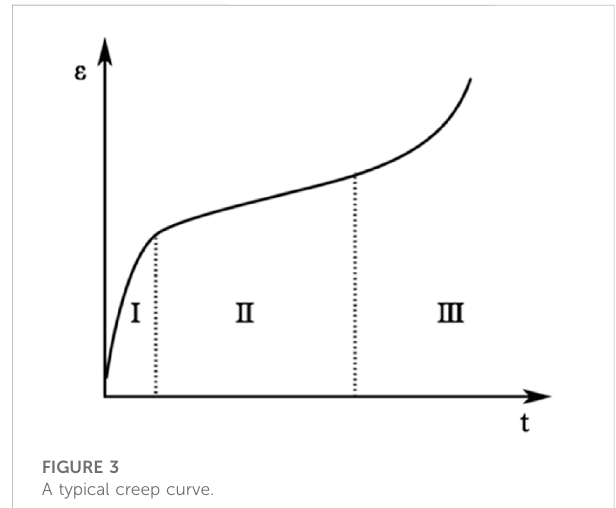
FIGURE 3 A typical creep